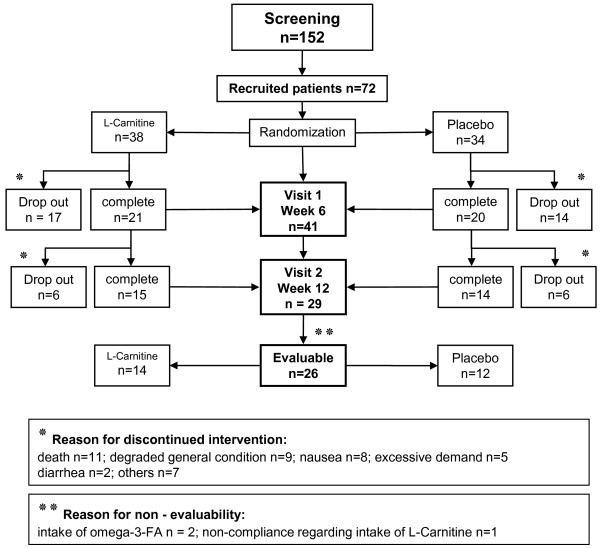
Flow chart of the trial.